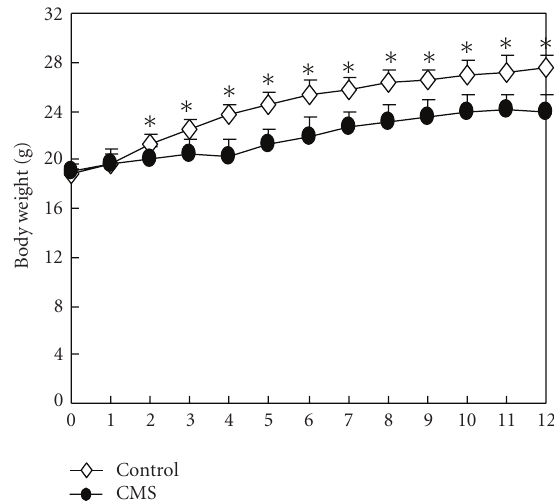
Figure 2: Body weight (in grams) in CMS and control groups during the CMS period ( n = 20 per group). All mice were weighted weekly from Week 0 (initial week) to Week 12 of the procedure every Monday following 12-hour period of food and water deprivation. Values are means ± SEM. ∗ P < . 05 versus the stressed group.